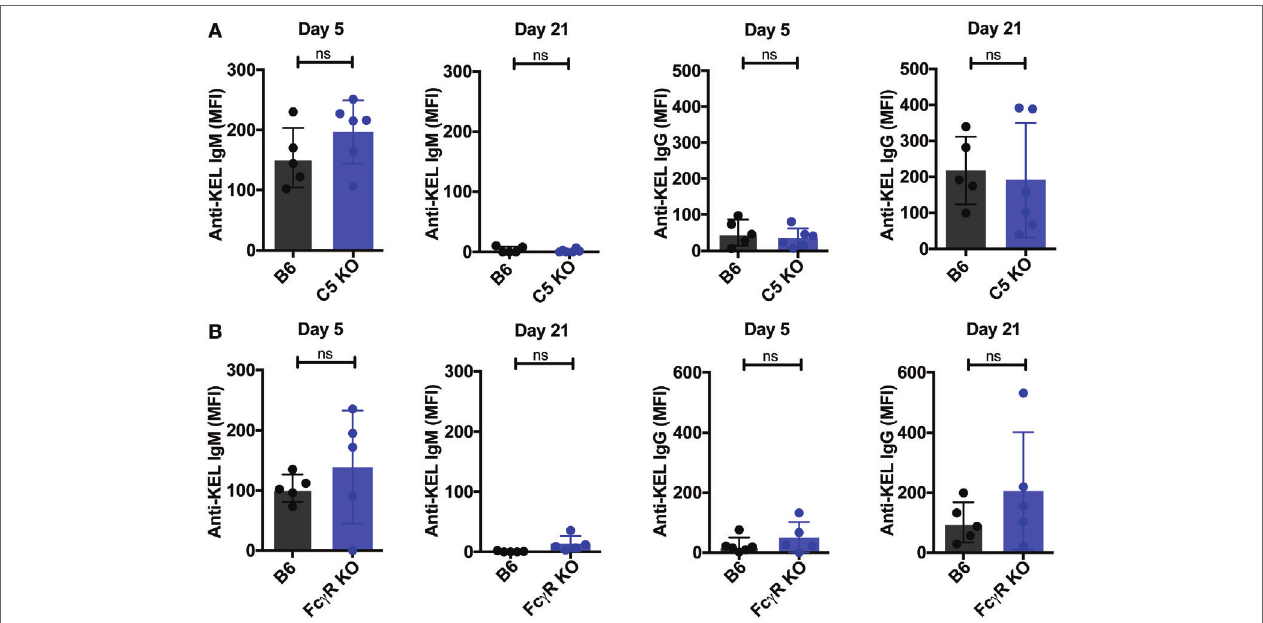
FigUre 8 | C5 KO and Fc γ gamma receptor (Fc γ R) KO mice exhibit no increase in the anti-KEL antibody response following KEL RBC transfusion. (a,B) B6, C5 KO, or Fc γ R KO mice were transfused with KEL RBCs. Anti-KEL IgM and IgG was measured at days 5 and 21 in the serum of C5 KO (a) or Fc γ R KO mice (B) . (a,B) ns = not significant. Means ± SD